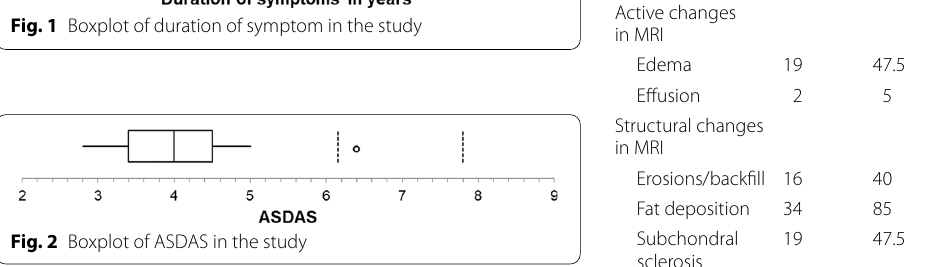
Table 1 Active and structural imaging features in sacroiliitis Number Percentage Number of Percentage of cases total cases